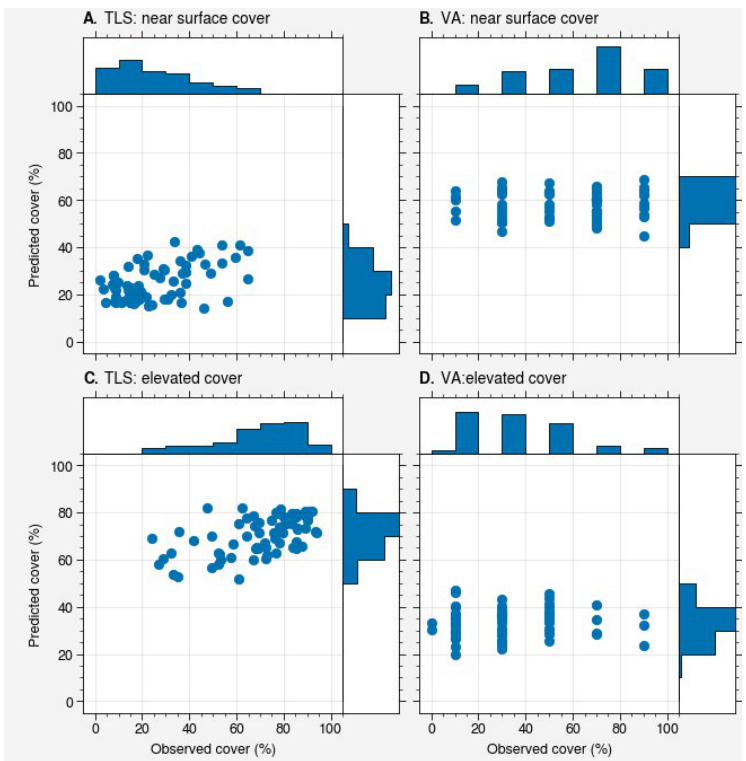
Figure 4. Joint plots comparing cover (%) of the near-surface ( A , B ) and elevated ( C , D ) layers. ( A , C ) show the TLS observation against the random forest prediction (trained using TLS data). ( B , D ) show the visually assessed cover against the random forest prediction (trained using visually assessed